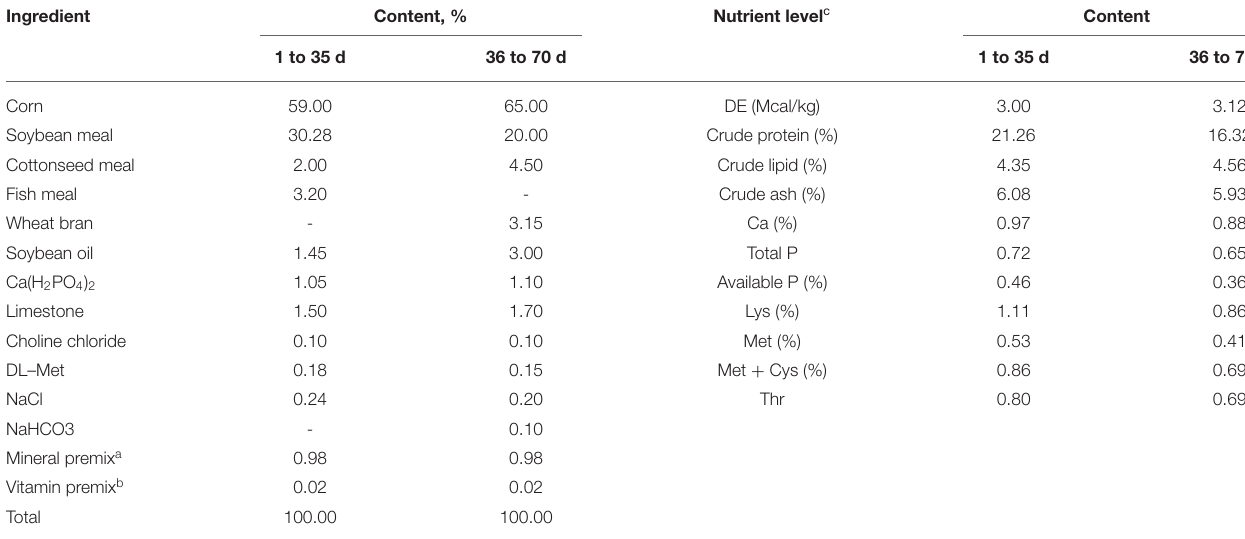
TABLE 1 | Composition of the basal diet and nutrition level (dry matter).